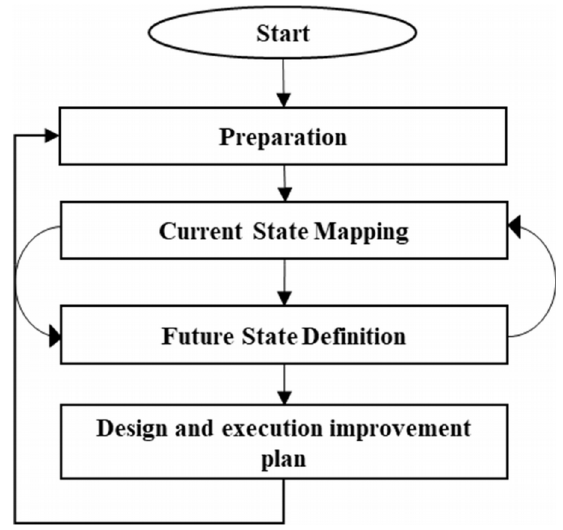
Figure 2. Workflow of the ErgoVSM Methodology